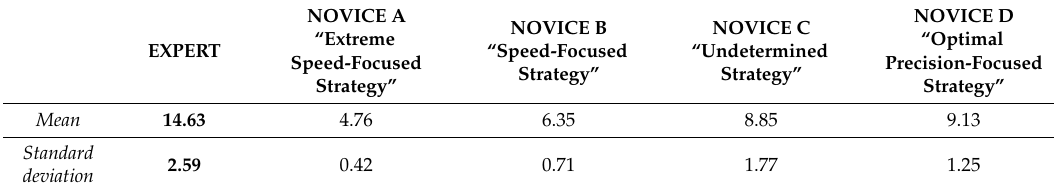
Table 3. Expert single session statistics for the parameter relative to task time (in seconds) compared with the statistics from the last of eight or ten training sessions of novice trainees A, B, C, and D in the same camera view conditions. Each statistic was computed on a total number of 80 trial